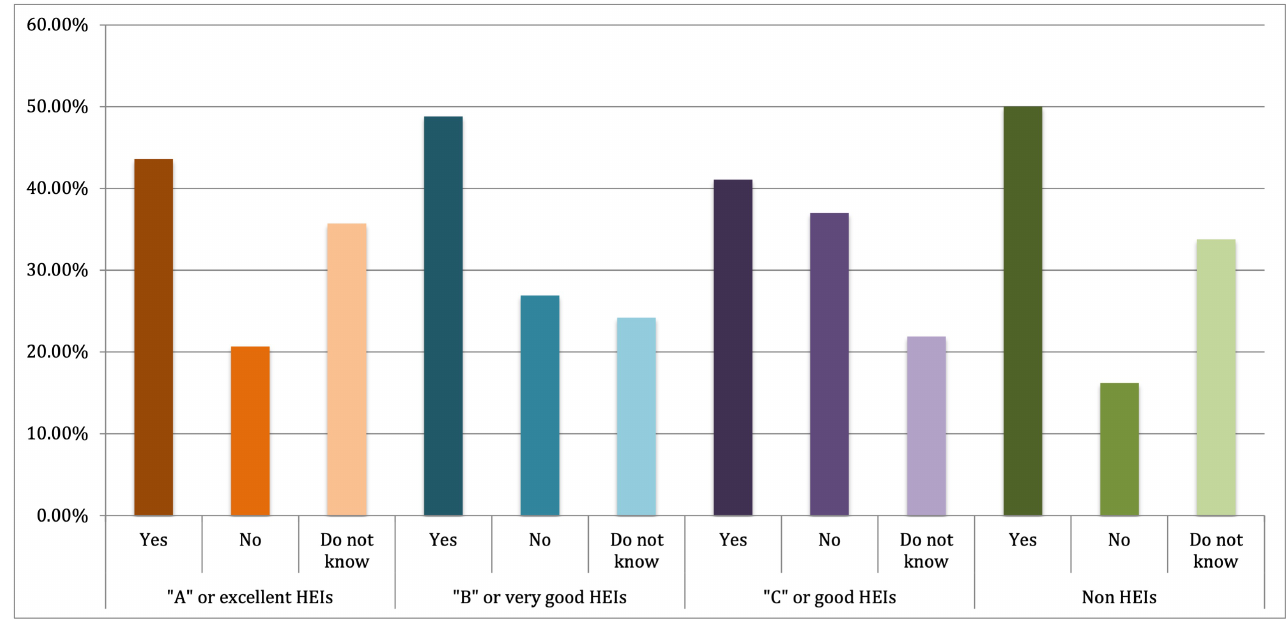
Figure 6. Indonesian scientists’ perceptions of the existence of their institutions’ policies and proce- dures related to research data